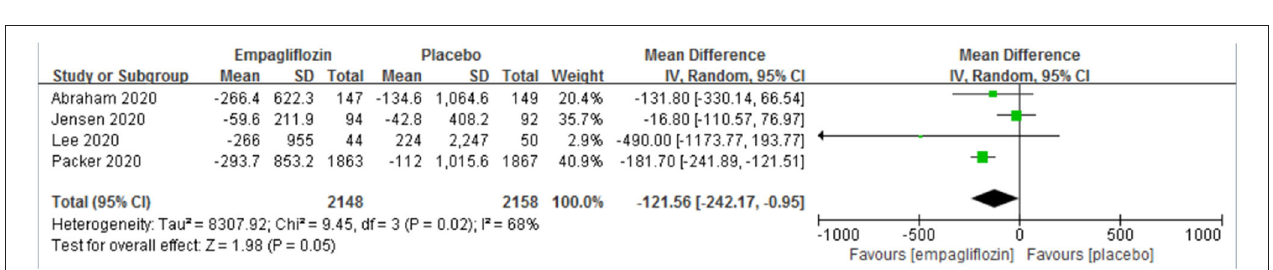
FIGURE 7 | Effect of empagliflozin on the change in body weight from baseline.